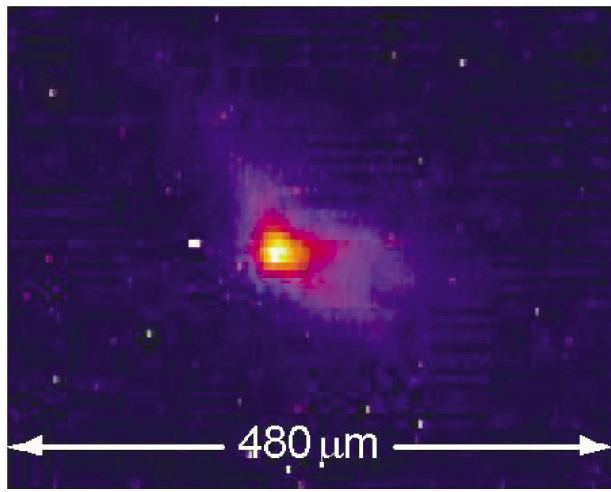
FIG. 21. (Color) False color CCD image of the PMQ focused electron beam. The rms beam size is 20 (cid:15) m in both x and y .